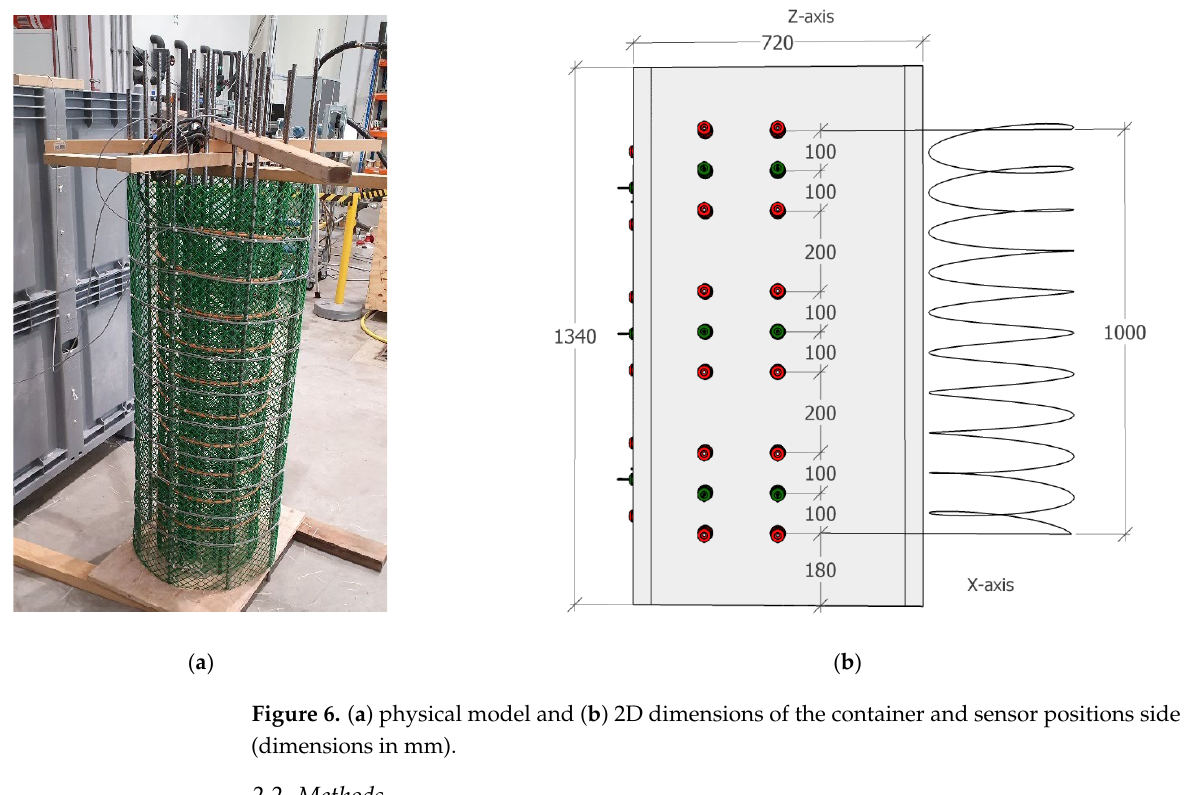
Figure 5. Experimental setup top view ( a ) and all dimensions and positions of sensors ( b ) in mm.